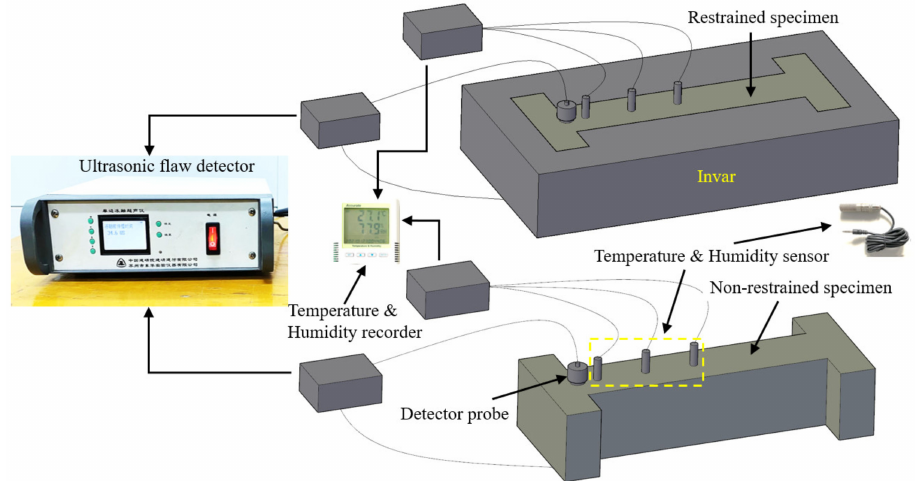
Figure 4. Quantitative characterization of damage of different concrete